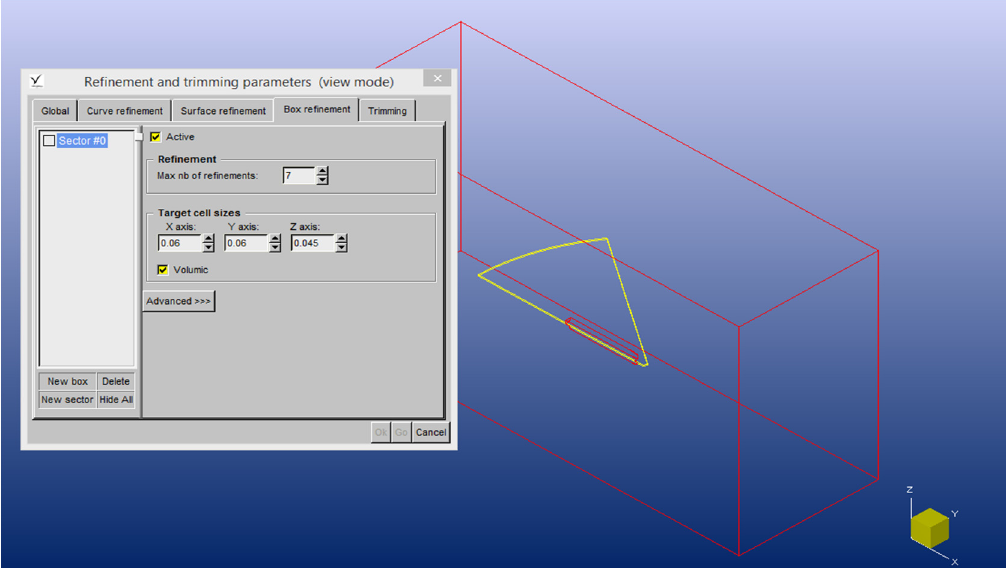
Figure 3. Box refinement for wave capturing.